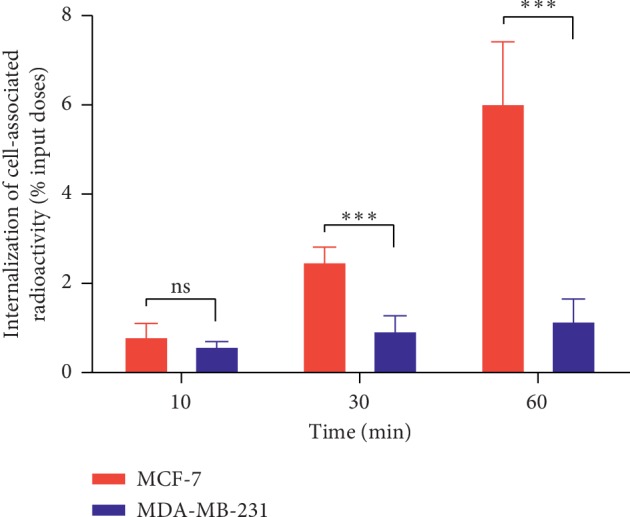

In vitro cell study. Cell internalization of [11C]-pictilisib in MCF-7 and MDA-MB-231 breast cancer cells at 10 min, 30 min, and 60 min. The internalization rate between MCF-7 and MDA-MB-231 cells was statistically significantly different at 30 min and 60 min (n = 3, mean ± SD) (∗∗∗P < 0.001, ns means P > 0.05).